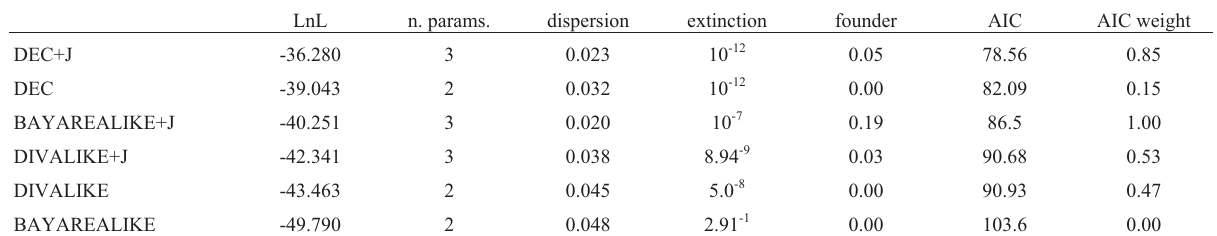
Table 2 - Comparison among the estimated models in `BioGeoBEARS’. For each implemented model in the analyses are shown: the log-likelihood val- ues (LnL), number of parameters (n. params), dispersion, extinction, founder, and values of Akakie’s Information Criteria (AIC and AIC weight). LnL n.